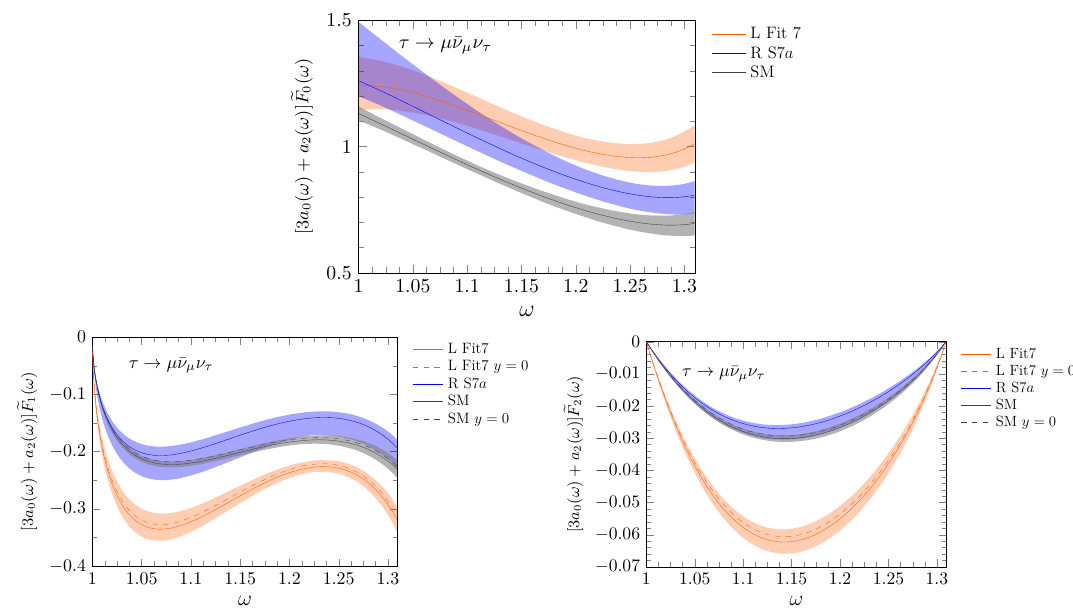
Figure 2 . Results for the functions [3 a 0 ( ω )+ a 2 ( ω )] e F µ ¯ ν µ ( ω ) evaluated for the Λ b → Λ c τ ( µ ¯ ν µ ν τ )¯ ν τ 0 , 1 , 2 decay, keeping the muon mass finite, and obtained from the SM and the NP models corresponding to Fit 7 of ref. [42] and Fit 7a of ref. [45]. Error bands account for uncertainties induced by both form-factors and fitted Wilson coefficients (added in quadrature). In the SM and Fit 7 cases, we also display the results obtained neglecting the muon mass, as in eqs.